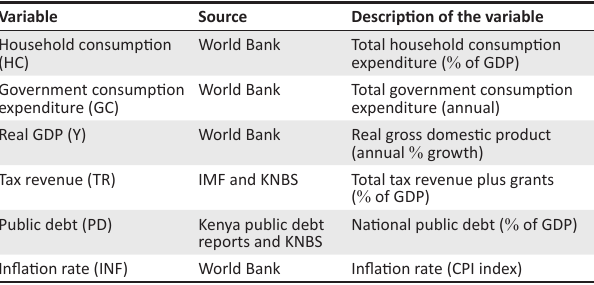
TABLE 1: Data source.